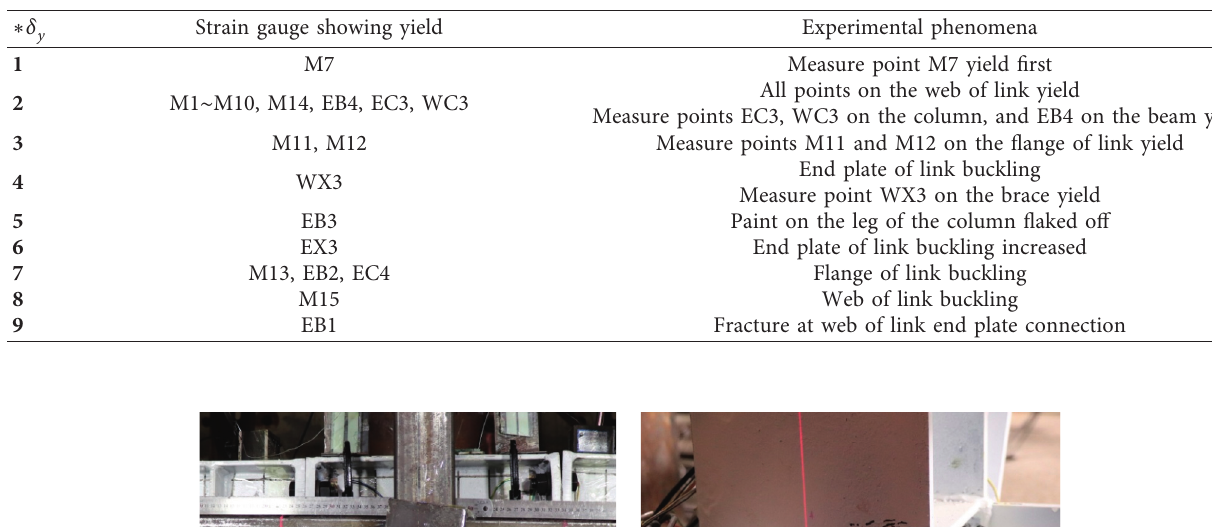
Table 7: Experimental phenomena of specimen PDKB-1